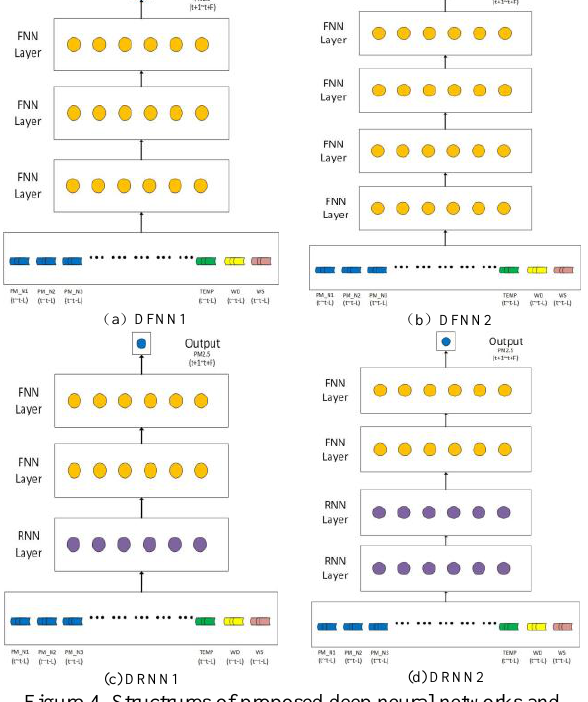
Figure 4. Structrures of proposed deep neural networks and